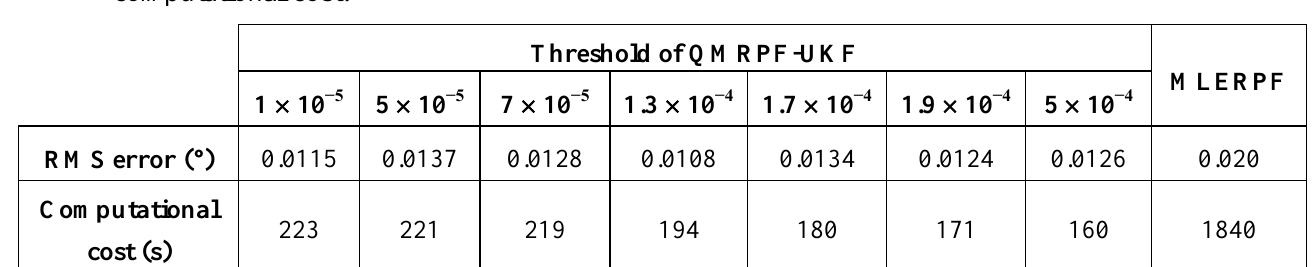
Table 1. Comparison of QMRPF-UKF with MLERPF in terms of RMS error and computational